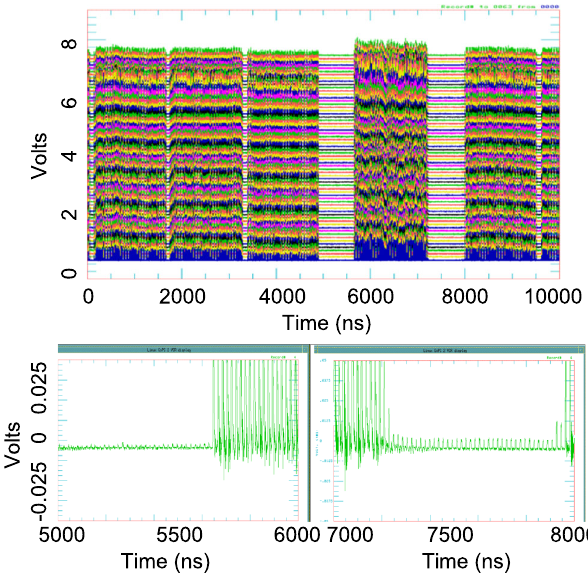
FIG. 6. Wall current monitor plot for slip stacked beam during development of ( 5 þ 2 ) slip stacking. For the upper panel, the horizontal axis shows time for (nearly) one Main Injector revo- lution. Vertical axis shows bunch intensity after recapture with selected turns offset vertically. The lower panel shows portions of one turn, just before extraction, expanded to show the beam captured in the gaps for the rising (left) and falling (right) edges of pbar extraction kicker pulse. This figure is from Ref.